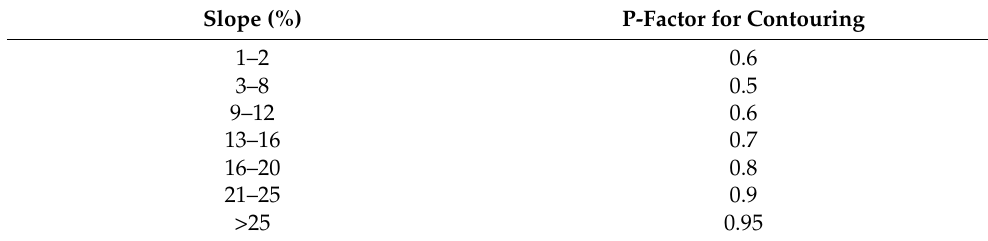
Table 3. P-Factor for contour support practices for different slope gradients